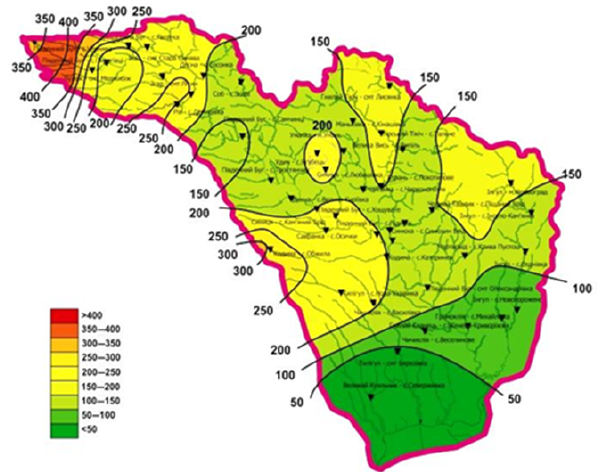
Figure 4. Distribution of the duration of sloping influx during the spring flood in the basin of the Southern Bug,